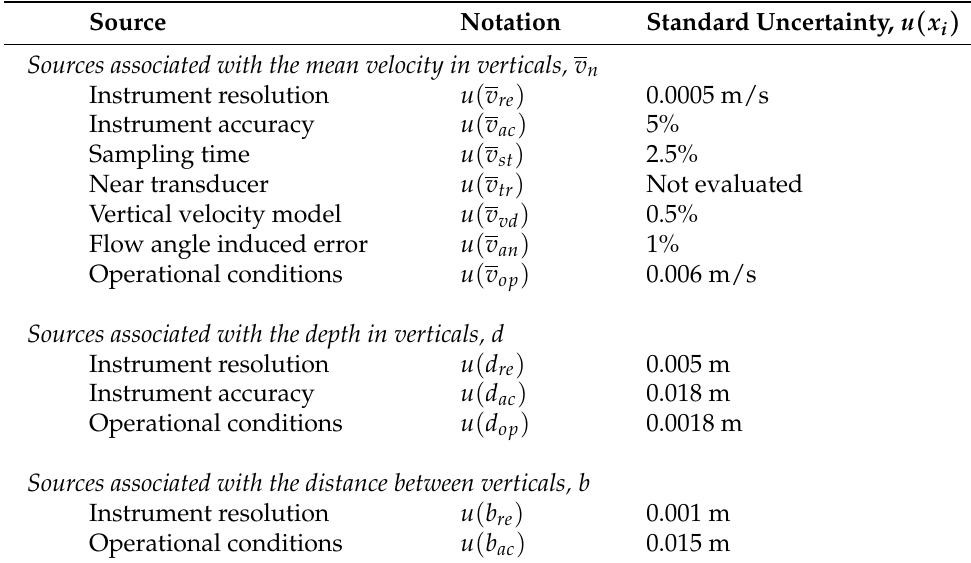
Table 1. Elemental uncertainty sources associated with the stream discharge measurement using Qliner ADCP. Source Notation Standard Uncertainty, u ( x i